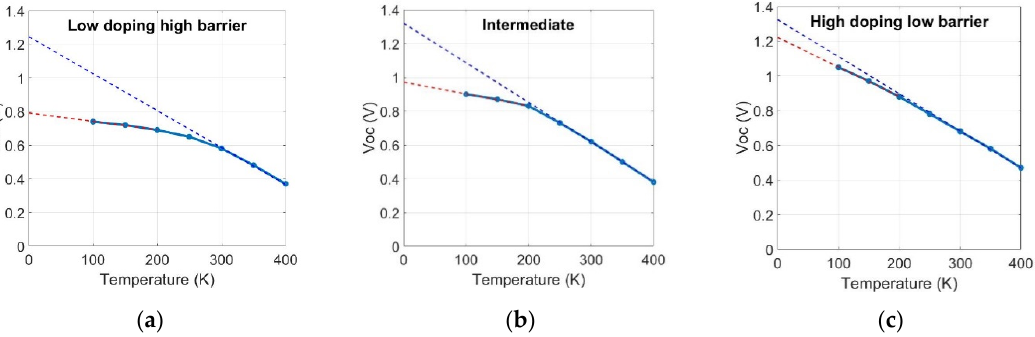
Figure 8. Voc against temperature plots for ( a ) the low-doping high-barrier case, ( b ) the intermediate case and ( c ) the high-doping low-barrier case with the highest illumination level (100% transparency). The extrapolations of Voc to 0 K in the low- and high-temperature regime are shown in red and blue dotted lines, respectively.